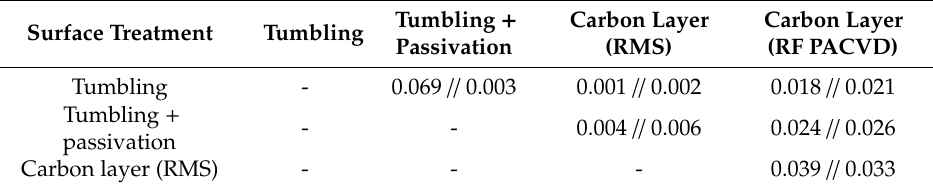
Table 4. Statistical analysis (p-values) of the surface roughness for X39Cr13 //